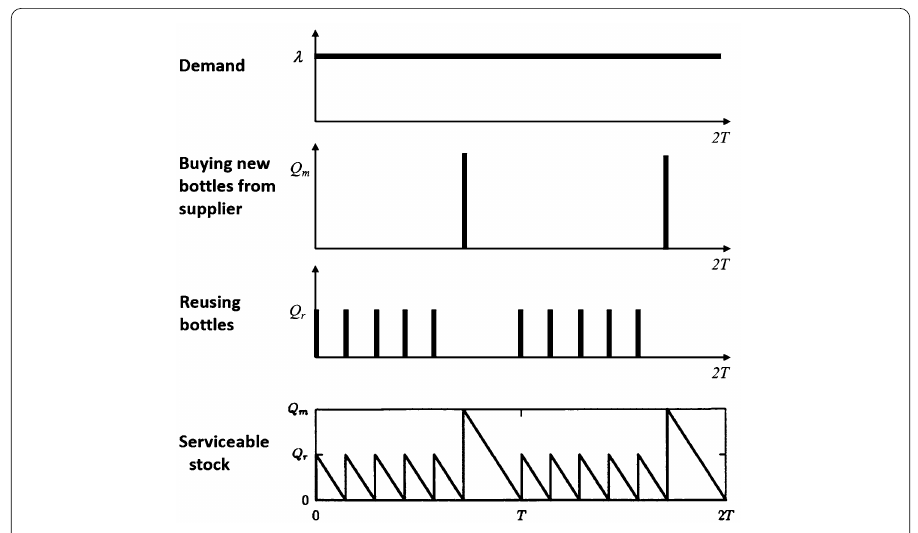
Figure 2 Inventory stock model according to Teunter [15], for the case M = 1 and R = 5